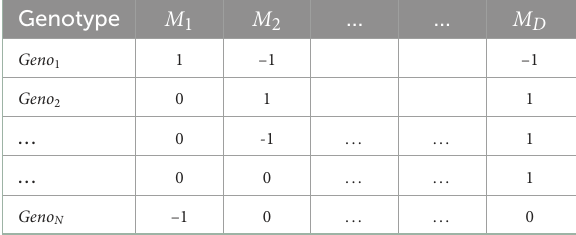
TABLE 1 An example of genotyped data.